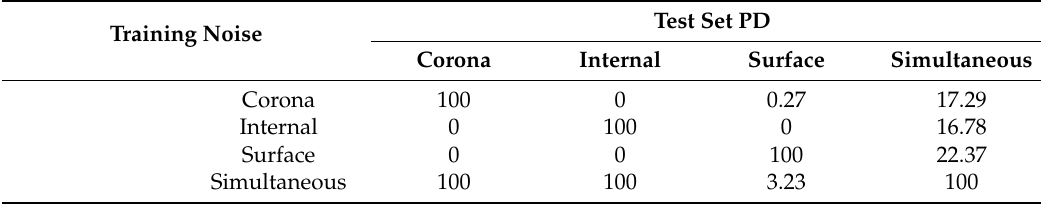
Table 3. Classification efficiency (%) of the OCSVM detecting different types of